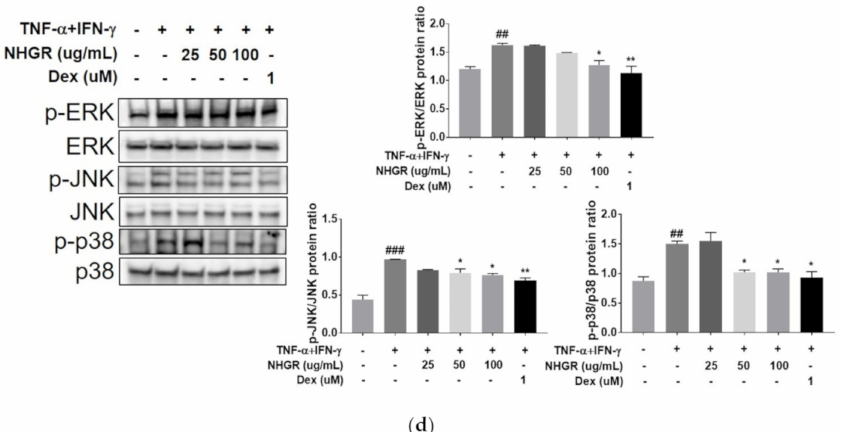
Figure 7. E ff ect of Siraitia grosvenorii residual extract (NHGR) on the protein expression of filaggrin and chemokine and activation of ERK, JNK, and p38 MAPKs from TNF- α / IFN- γ -induced HaCaT cells. ( a ) Cell viability, ( b ) filaggrin expression, ( c ) chemokine (RANTES, TARC, and TSLP) production, and ( d ) phosphorylation of ERK, JNK, and p38 MAPKs. Expression of protein and phosphorylation of MAPKs were examined. Results are showed as means ± SEM ( n = 3). # p < 0.05, ## p < 0.01 and ### p < 0.001 versus vehicle; * p < 0.05, ** p < 0.01 and *** p < 0.001 versus TNF- α / TNF- γ -treated